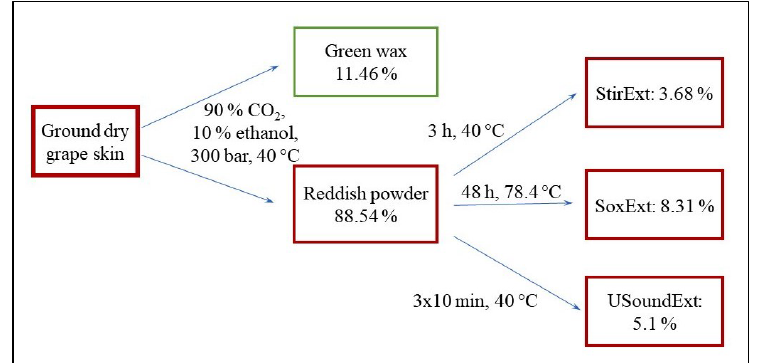
Figure 1. Schematic presentation of the extraction process, conditions and yield.